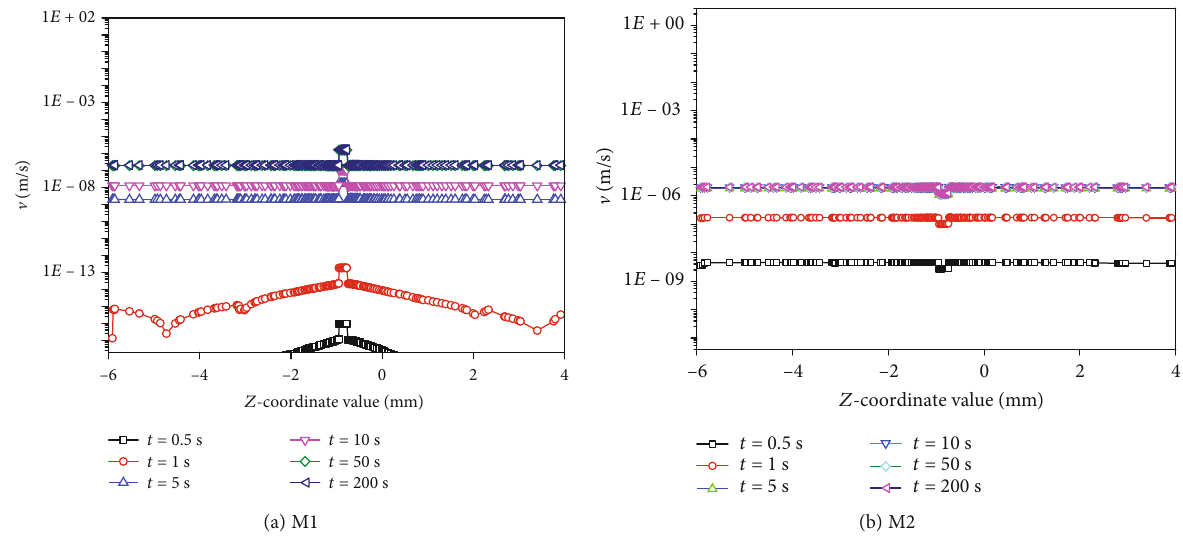
Figure 14: Evolution of the fl ow velocity at the outlet boundary along the direction of fracture aperture thickness.